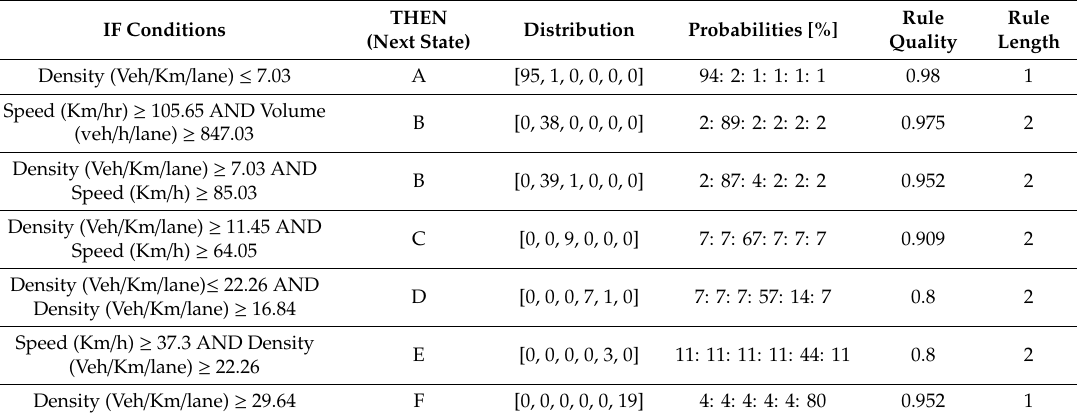
Table A1. If–then rules for the next 5-min horizon.